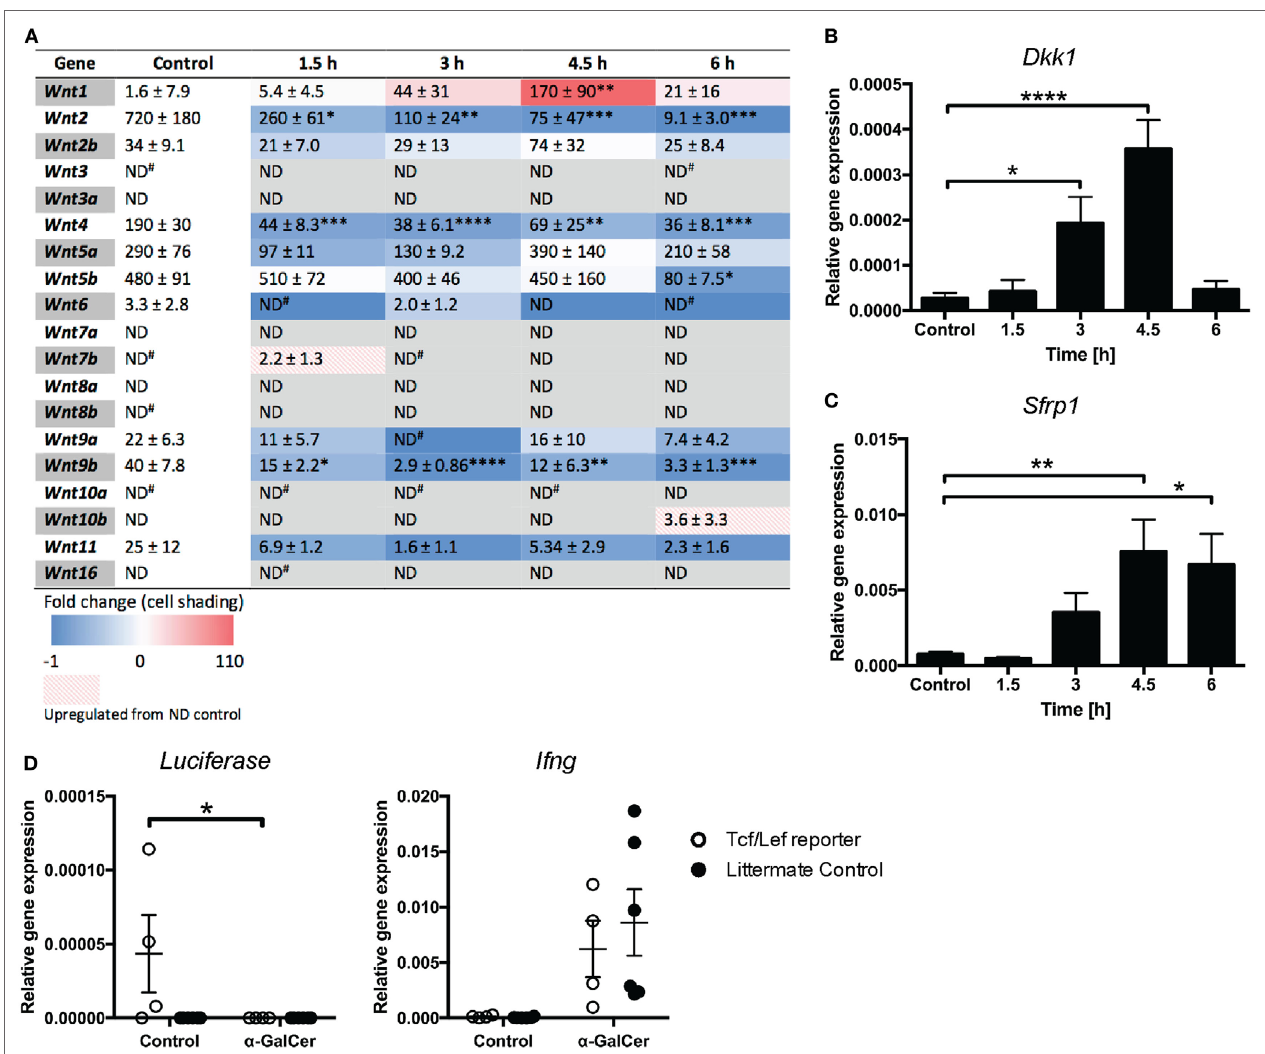
FigUre 5 | Wnt/ β -catenin signaling is suppressed in the liver upon α -galactosylceramide ( α -GalCer) challenge. (a) Heat map of fold change of Wnt ligand mRNA expression in the liver compared to vehicle control-injected mice determined by quantitative RT-PCR (blue = downregulation, red = upregulation). Numbers within the table represent relative gene expression for individual genes normalized to Hprt , expressed as mean ( × 10 − 5 ) ± SEM ( × 10 − 5 ). The mRNA expression of Dkk1 (b) and Sfrp1 (c) was determined. (D) Tcf/Lef TOPFlash mice, expressing luciferase as a reporter of Tcf/Lef transcriptional activity, and transgene-negative littermate controls were challenged with α -GalCer or vehicle control for 6 h. Luciferase expression in liver tissue was determined by quantitative PCR. Expression of Ifng was determined as a marker of activation after α -GalCer challenge. Data are means ± SEM of four to nine mice per time point from three (a–c) or two (D) independent experiments. One-way ANOVA with Dunnett’s (a–c) and two-way ANOVA with Bonferroni’s (D) correction for multiple comparisons; * p < 0.05, ** p < 0.01, **** p <